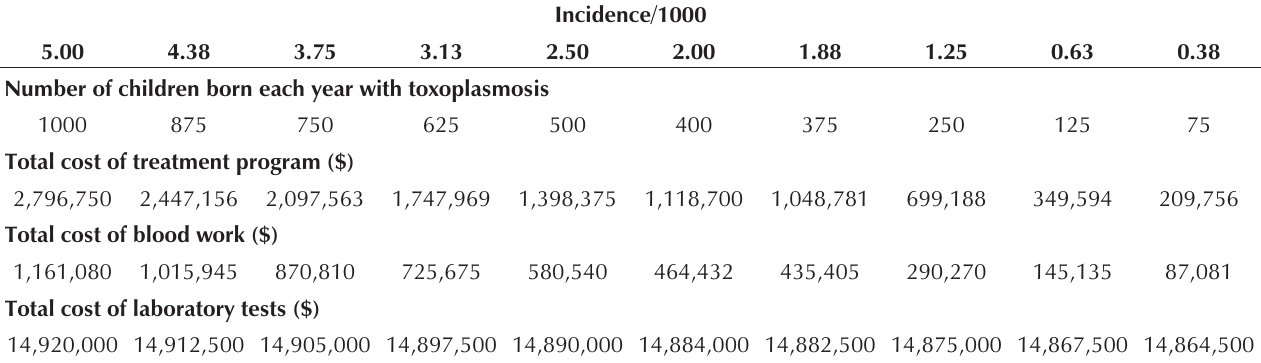
Sensitivity table for a range of incidences of congenital toxoplasmosis